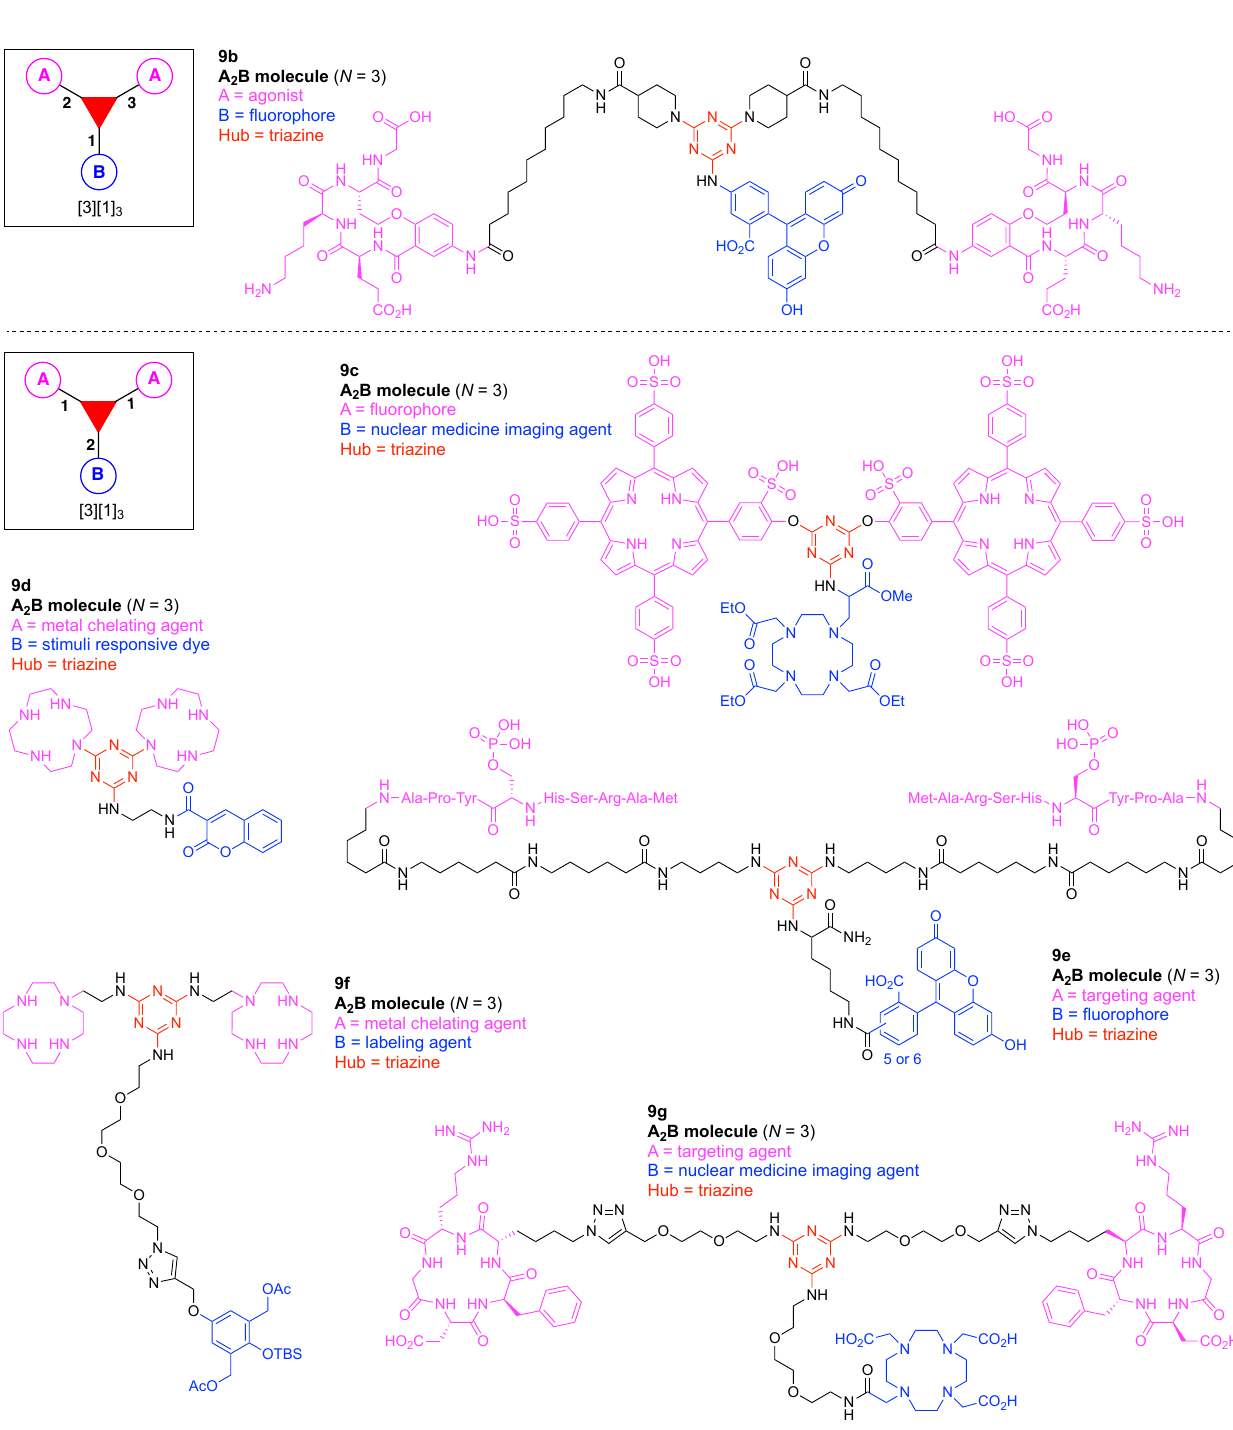
Figure 36. Examples wherein each contains a single triazine hub with A 2 B substituents. A quinone-methide precursor for DNA alkylation ( 9f ) has been developed (Figure 36) [225]. The pre-alkylator is composed of a triazine hub and three functional units: (A) two copies of cyclen to bind bivalent metals such as Zn 2+ , Ni 2+ , and Cd 2+ , and (B) a quinone-methide precursor containing a tert -butyldimethylsilyl (TBS) group, which can be deprotected by treatment with KF. This construct ( 9f ) has composition A 2 B and architecture [3][1] 3 . A triazine-based modular platform ( 9g ) was developed for targeted PET imaging (Figure 36) [226]. The platform is composed of a triazine hub and three functional units: (A) two copies of a cyclo(RGDfK) peptide for targeting integrin α v β 3 receptors,